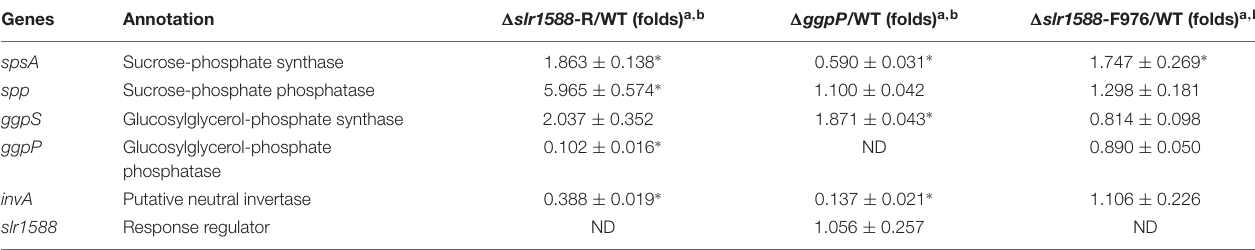
TABLE 1 | Effects of gene deletion on transcript levels of genes encoding proteins involved in sucrose or glucosylglycerol (GG) metabolism. Genes Annotation (cid:49) slr1588 -R/WT (folds) a , b